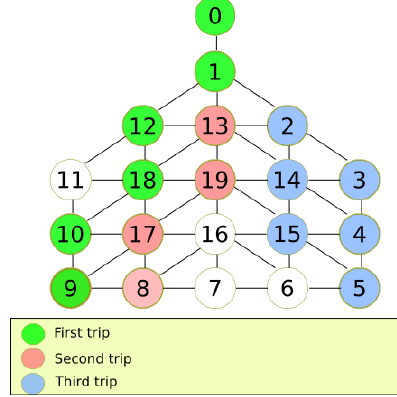
Figure 6. Reconnaissance of the Data Foraging Graph (DFG) G 3 . Each trip can be different. The base station is placed at node 0. The Mobile Data Forager (MDF) is restricted to visit 10